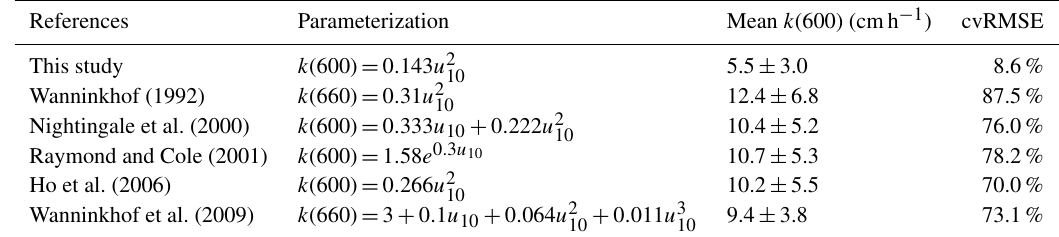
Table 2. Gas transfer velocities determined from this study and published parameterization.